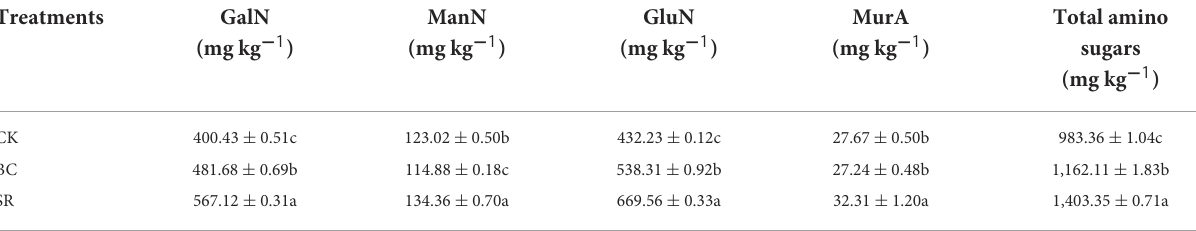
TABLE 3 Effect of straw and straw biochar on soil amino